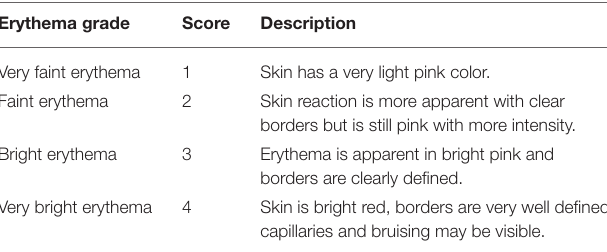
Figure 4 , by subtracting the background. The white